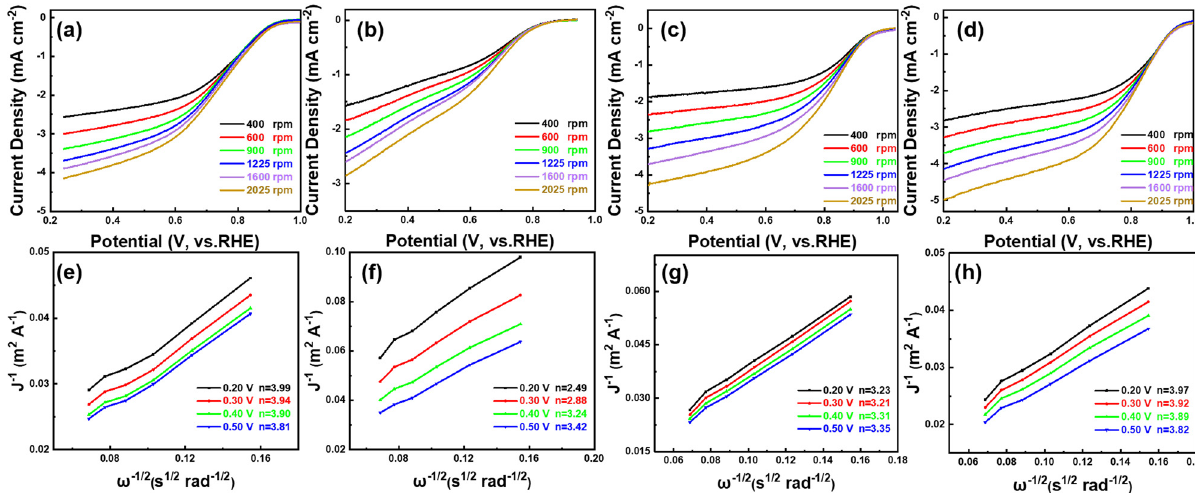
Figure 5: LSV curves with various rotation rates of ( a ) Pt/C, ( b ) FGN - 6, ( c ) FGN - 7, and ( d ) FGN - 8. K – L plots of ( e ) Pt/C, ( f ) FGN - 6, ( g ) FGN - 7, and ( h ) FGN - 8 from 0.2 to 0.5 V ( vs RHE ) . All the LSV curves were tested in O 2 - saturated 0.1 M KOH solution with a scan rate of 5 mV s − 1